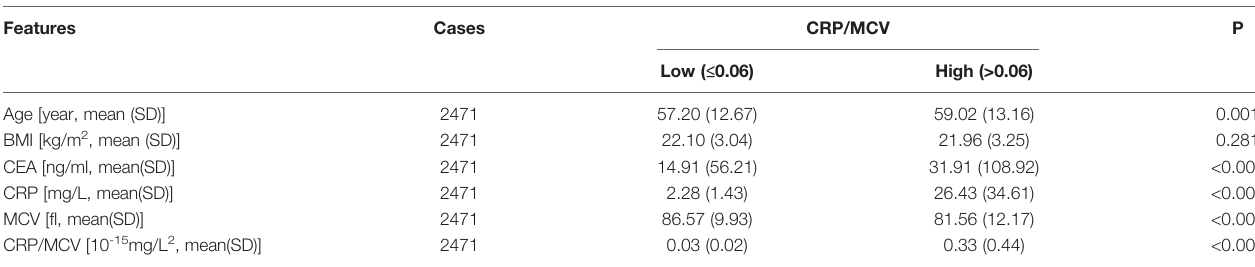
TABLE 2 | Baseline data based on continuous variables of CRP/MCV ratio.